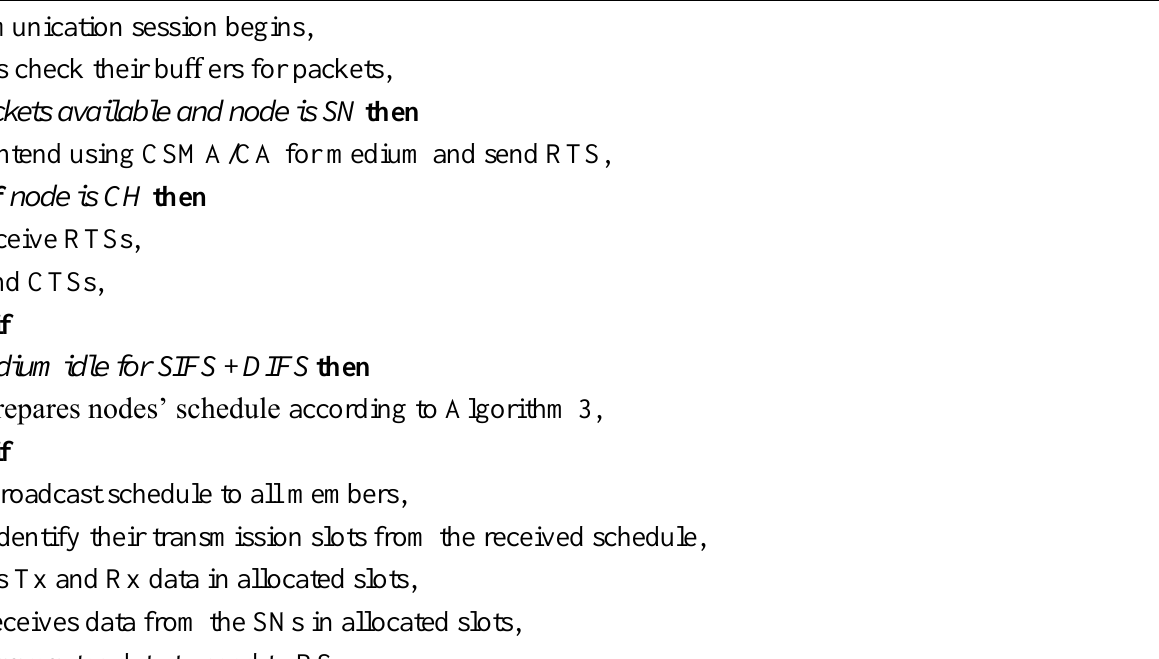
Figure 4. ( a ) Nodes’ Communication Session; ( b ) Nodes’ Contention Window. Algorithm 2 Intra-cluster Data Communication